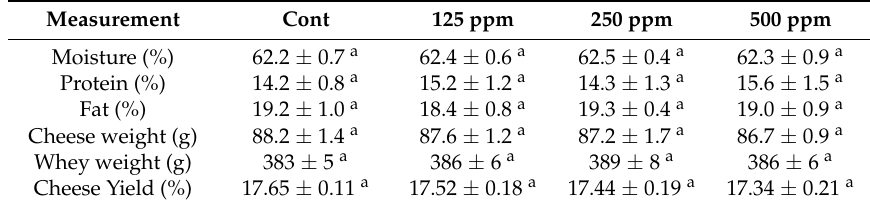
Table 2. Effect of free (+)-catechin on the composition, weight and yield of full-fat cheese on the day of manufacture.